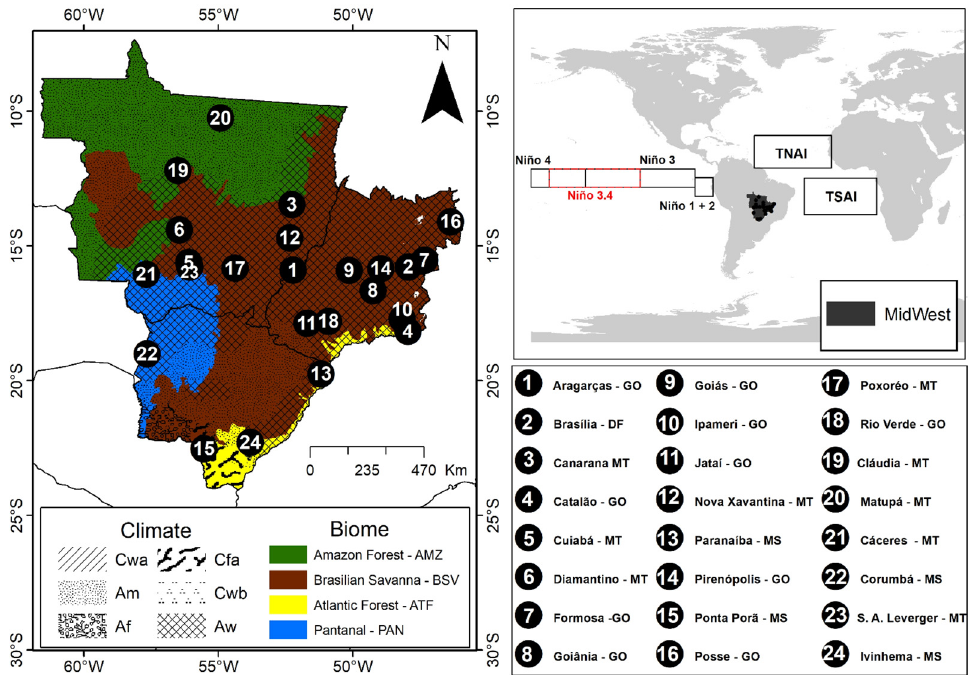
Figure 1. Location of Conventional Weather Stations, climates, and biomes of the Brazilian Midwest, and areas of operation of ENSO (Niño 1 + 2, Niño 3, Niño 3.4 and Niño 4) in the Equatorial Pacific, and Atlantic Dipole (TNAI and TSAI) in the Tropical